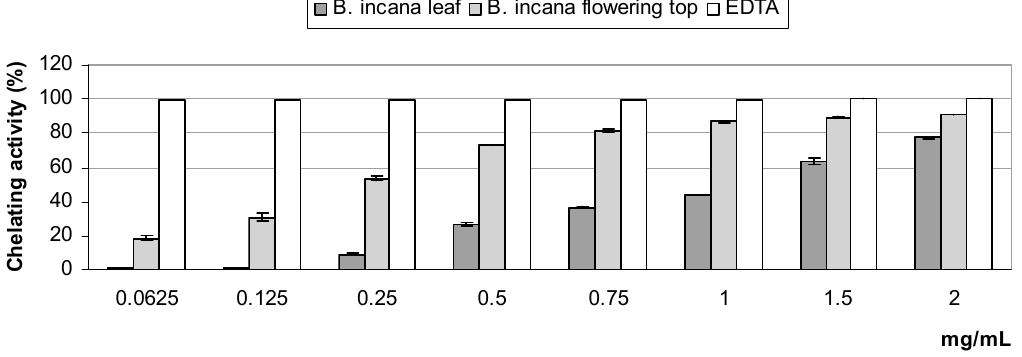
Figure 2. Free radical scavenging activity (2,2-diphenyl-1-picrylhydrazyl (DPPH) test) of B. incana leaf and flowering top hydroalcoholic extracts. Values are expressed as the mean ± SD ( n = 3).